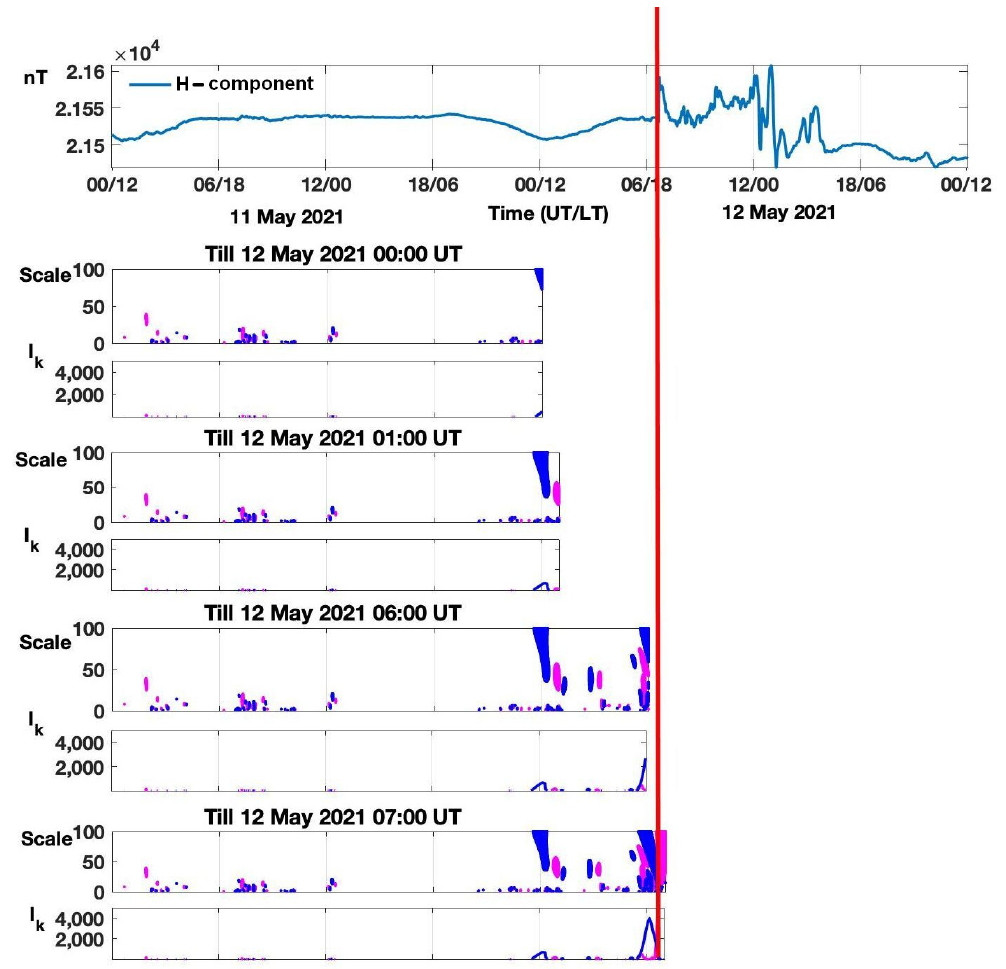
Figure 2. Results of estimation of losses P m for different basic wavelets, Paratunka observatory data were used. ( a ) January–June 2021; ( b ) first half of